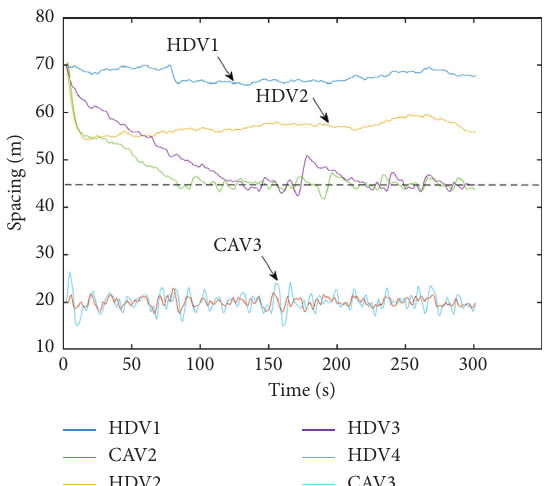
Figure 12: The spacing of formation (change 4).